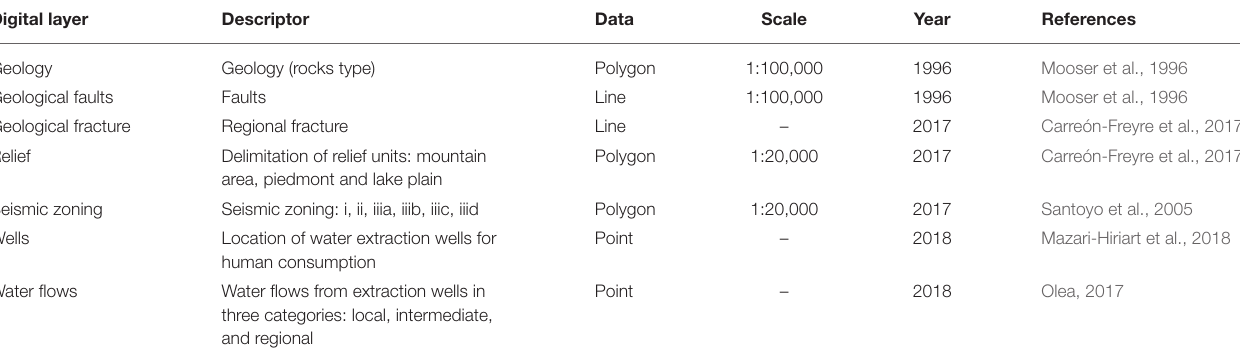
TABLE 1 | Mexico City’s spatial